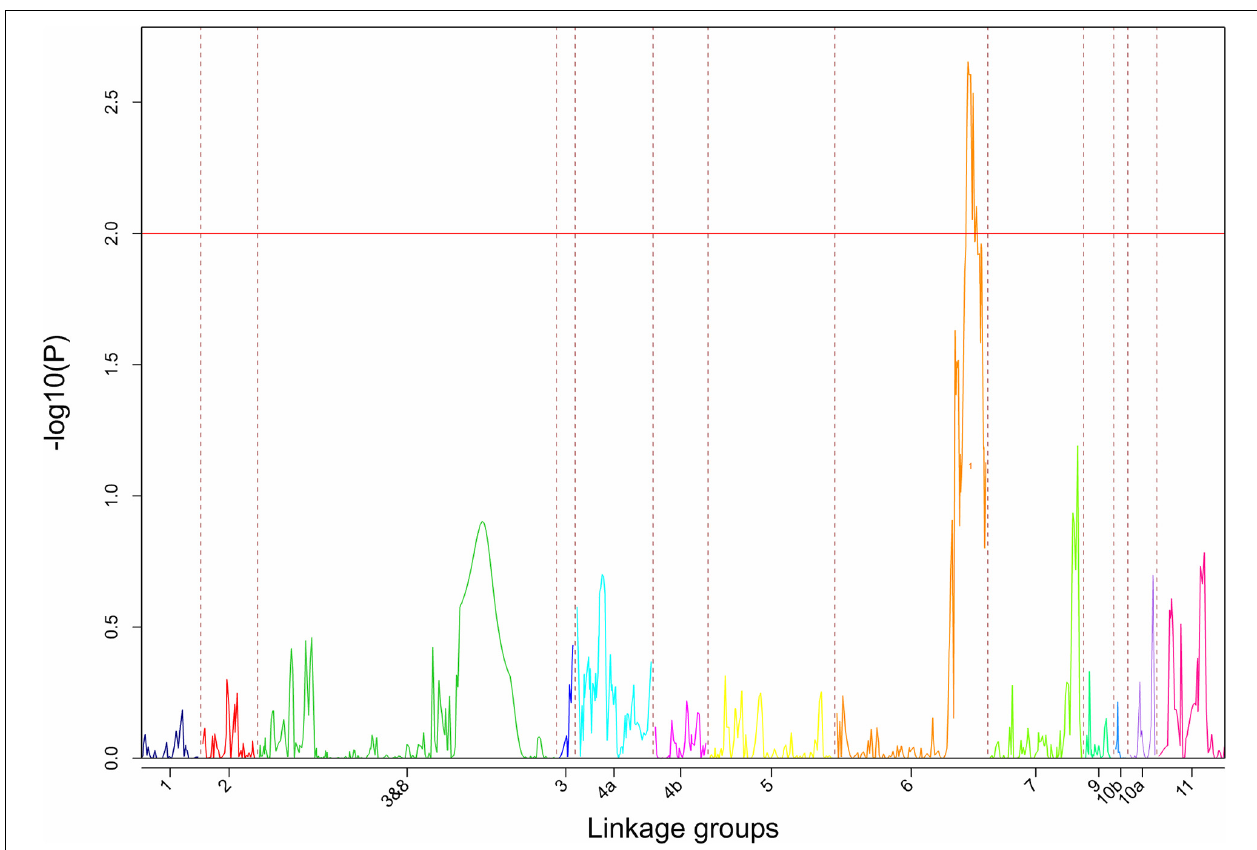
FIGURE 5 | The quantitative trait loci (QTL) for logit_PD identified by linkage QTL analysis as implemented in Genstat R (cid:13) for WindowsTM 20 th Edition (VSN International, 2019) using 786 markers of the segregation type AAAA × RA segregating only in